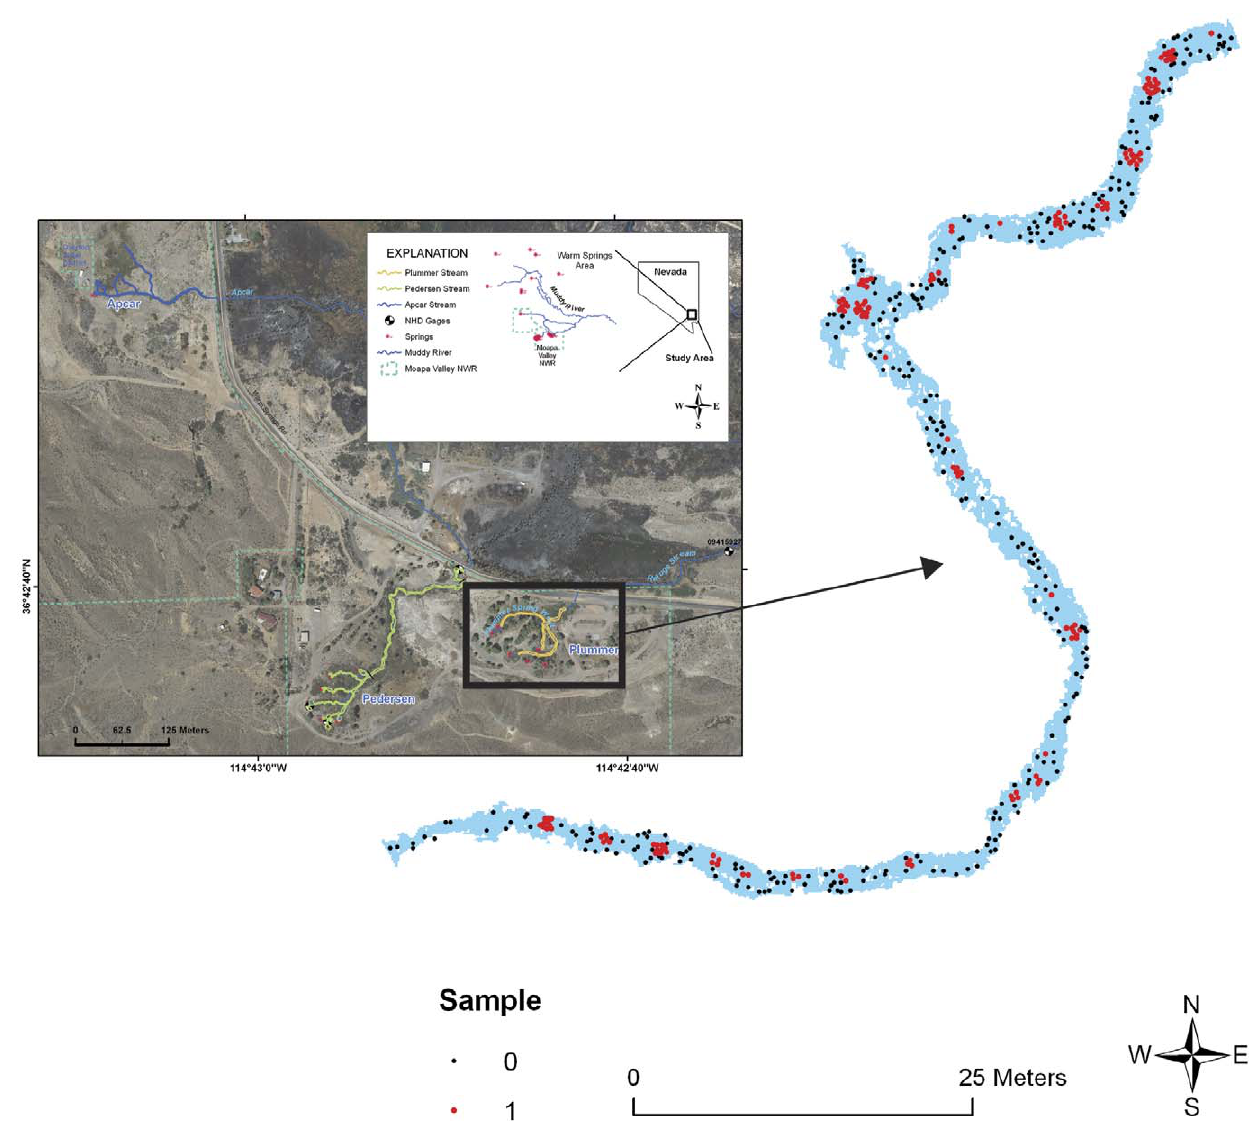
Figure 2. Random sample locations used for model development inside and outside of occupied dace patches in Plummer Springbrook. Snorkel surveys in the spring of 2009 were conducted to determine the locations of Moapa dace (shown in red), while absence locations were generated randomly outside of known dace sites with a GIS (309 absences and 141 presences).